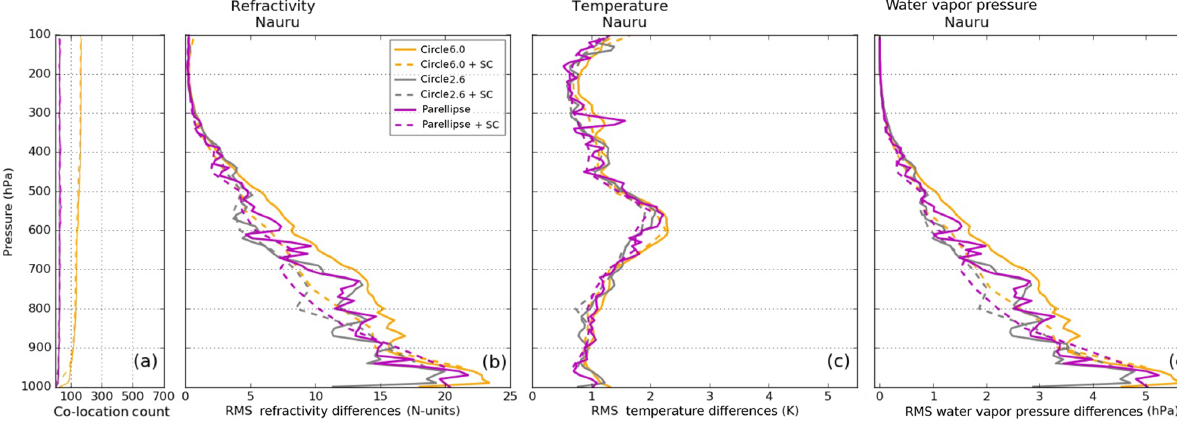
Figure 7. Same as Fig. 5 for Nauru,